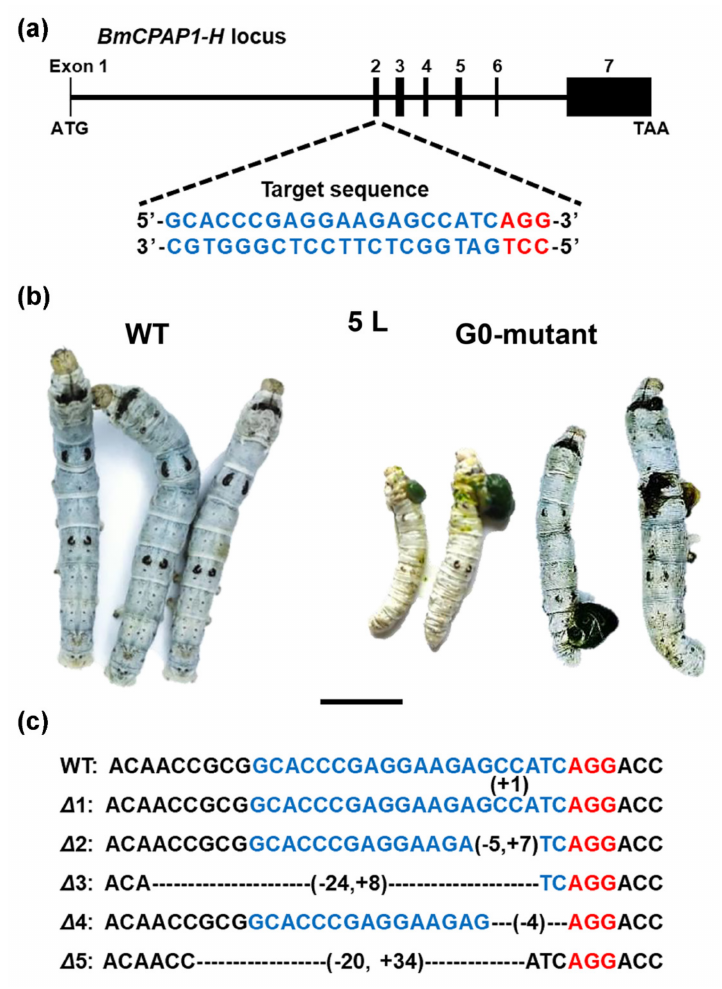
Figure 6. Disruption of BmorCPAP1-H using CRISPR/Cas9 in B . mori . ( a ) Genomic organization of BmorCPAP1-H ORF. The blue and red fonts indicate the target sequence and protospacer adjacent motif, respectively. CDS: coding sequence. ( b ) The phenotype of disruption of BmorCPAP1-H . In G0 generation, compared with wild-type (WT), the mutants exhibit the broken cuticle in the 5th instar larva (5 L). Bar, 1 cm. ( c ) Mutation site and recovered BmorCPAP1-H sequences in G0 mutants.